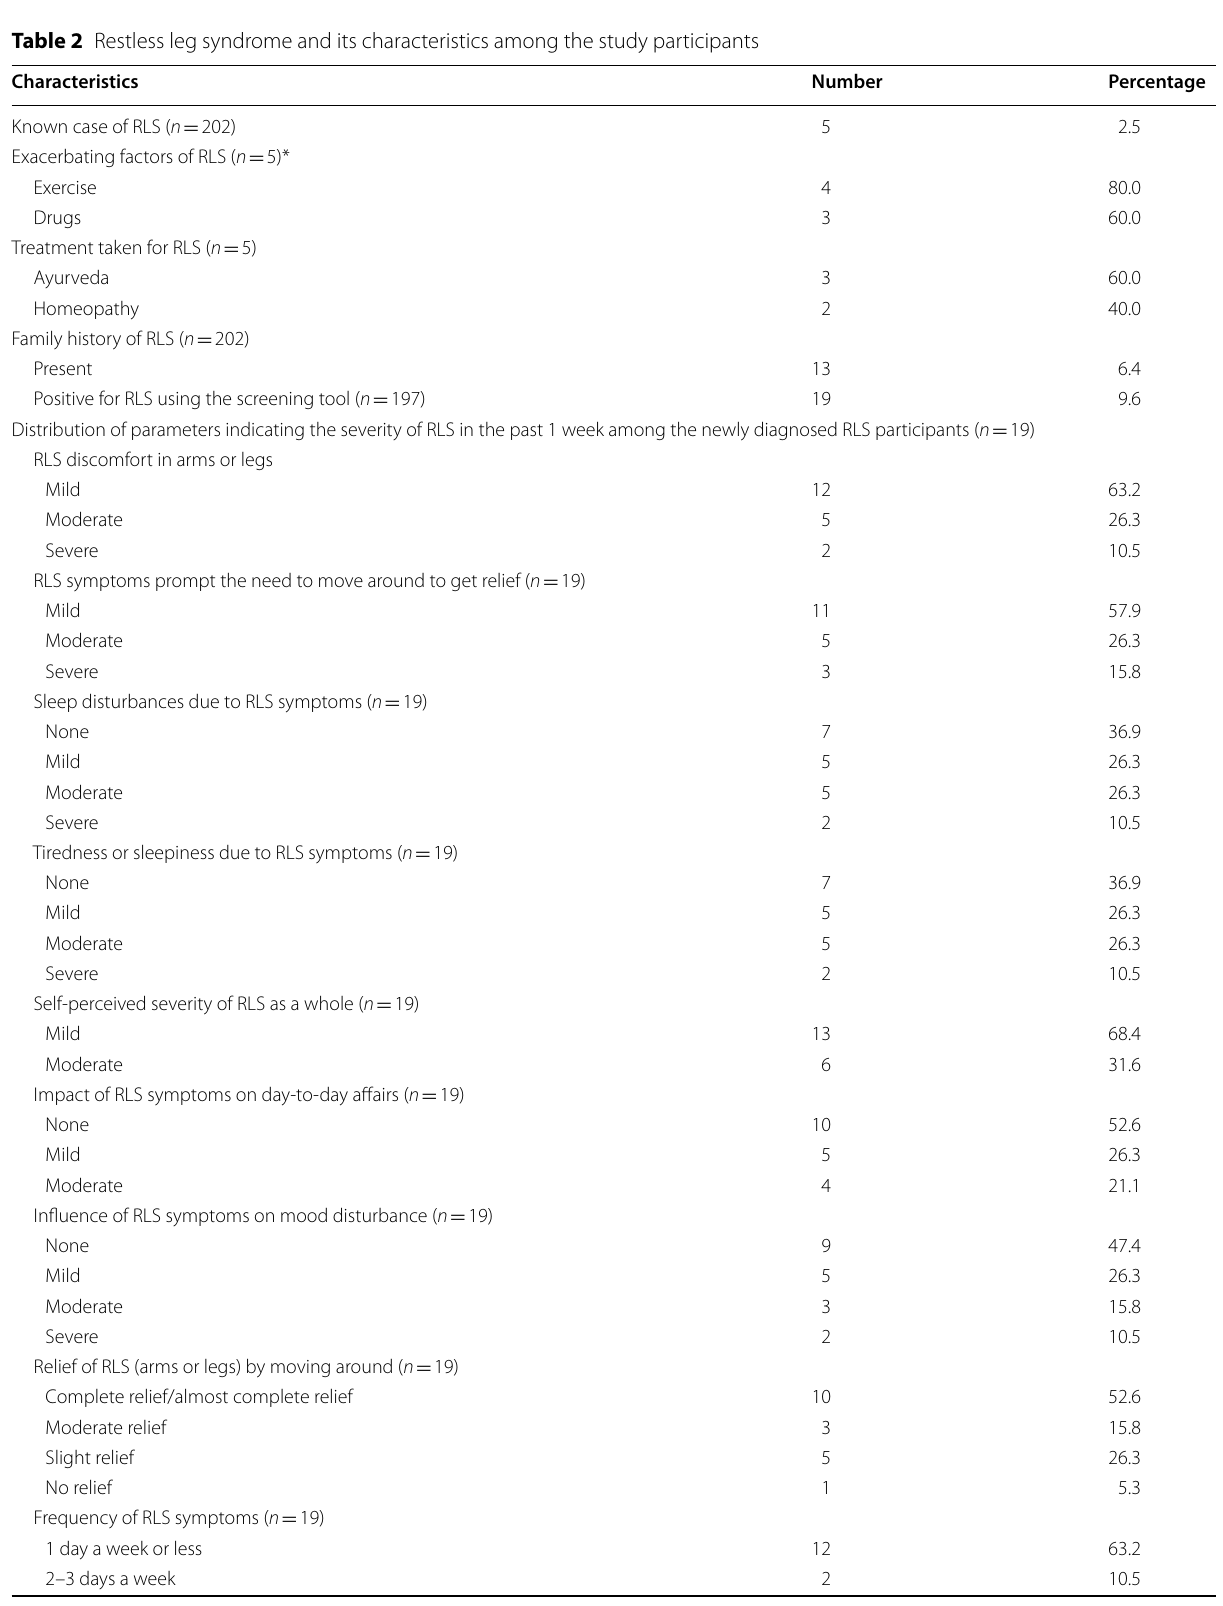
Table 2 Restless leg syndrome and its characteristics among the study participants